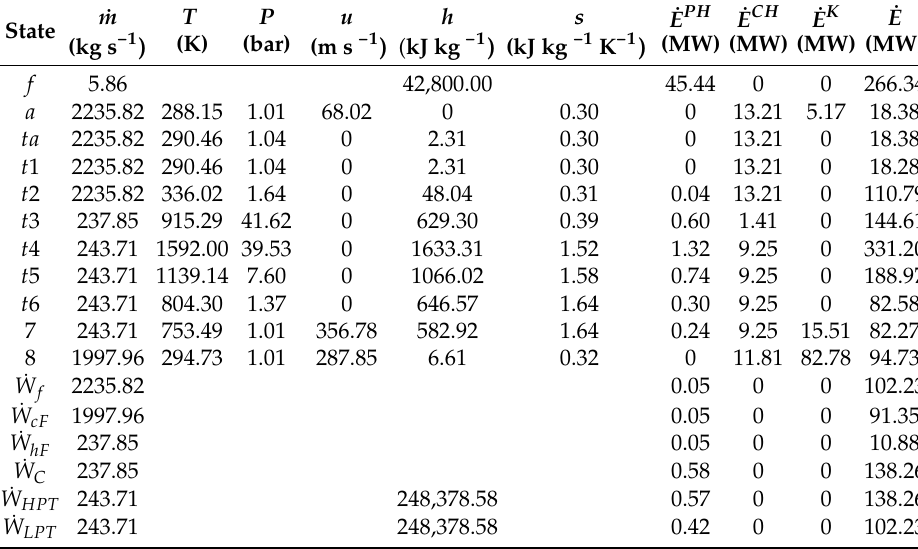
Table A1. Thermodynamic states of the turbofan engine under the design operating